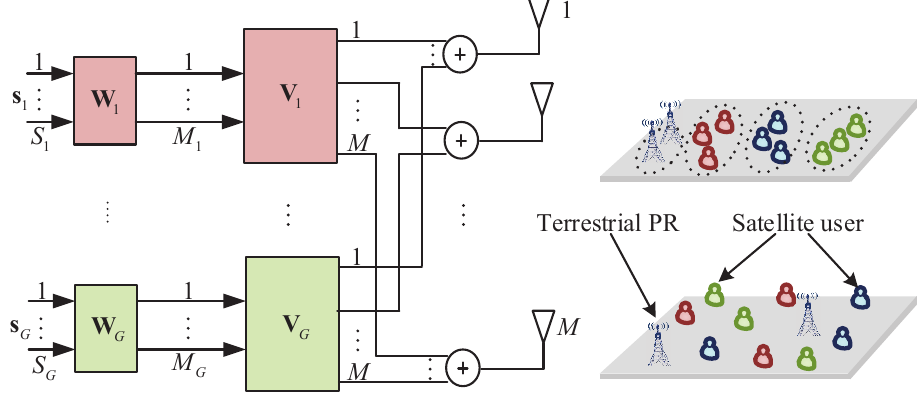
Figure 3. Framework of the joint spatial division and multiplexing (JSDM)-based radio resource management (RRM) in cognitive HTS